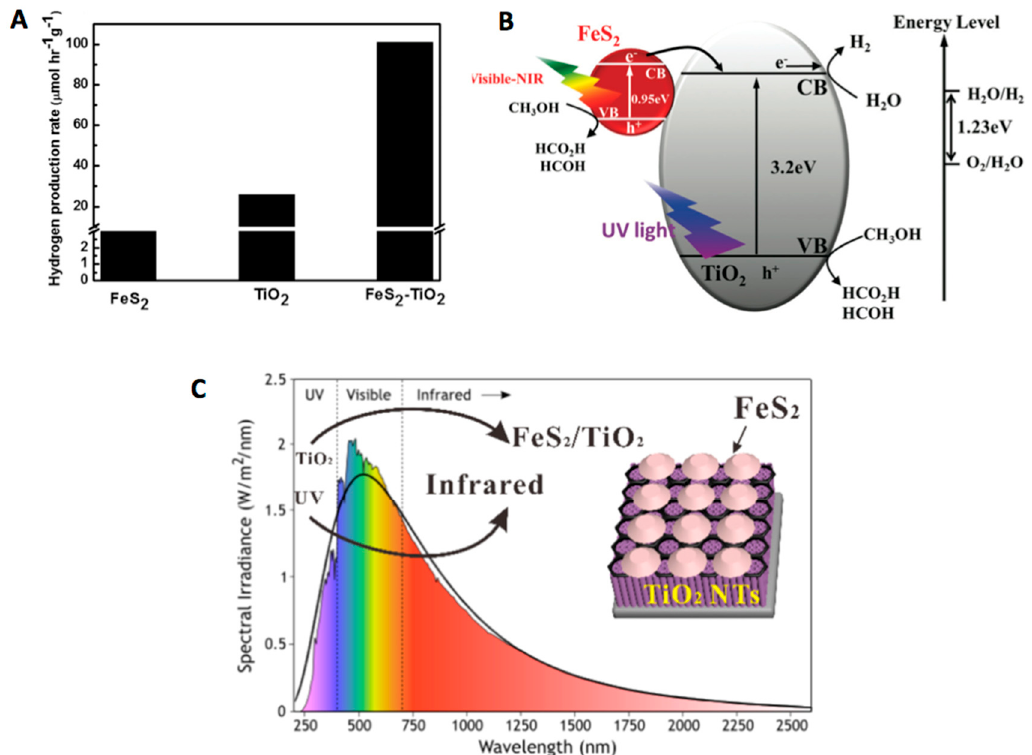
Figure 4. ( A ) Hydrogen evolution rate of FeS 2 , TiO 2 and FeS 2 -TiO 2 heterostructures under a 300 W xenon lamp; ( B ) schematic illustration of the photo-induced charge transfer in FeS 2 -TiO 2 heterostructures under UV, visible, and near-infrared light irradiation. ( A ) and ( B ) reprinted with permission from reference [61] ; ( C ) TiO 2 nanotubes doped with FeS 2 exhibit high photoelectrochemical performance in the infrared light region, reprinted with permission from reference [62] .